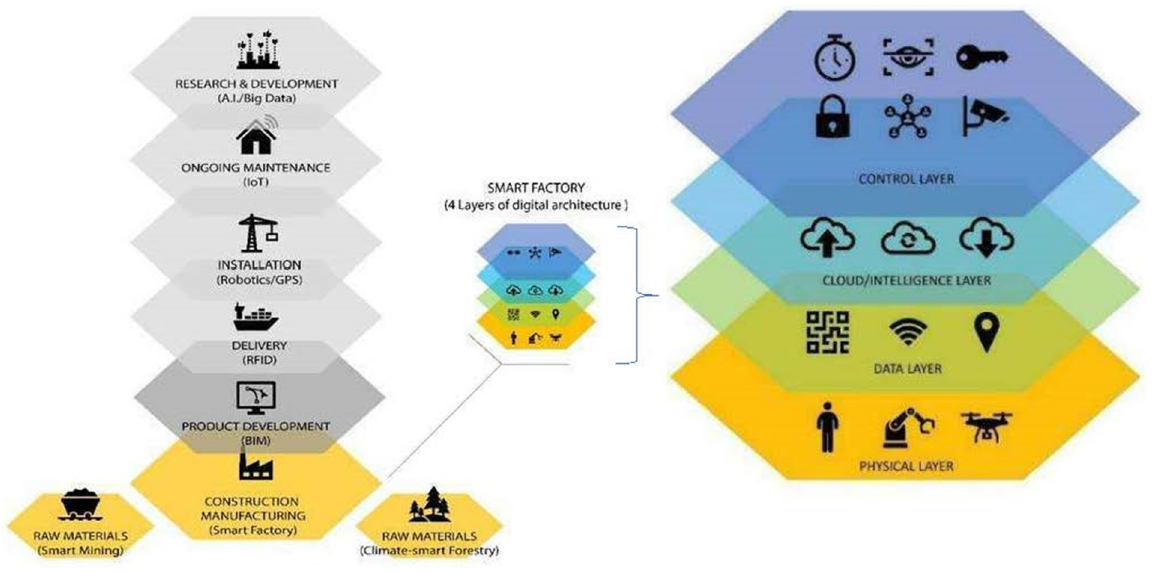
Figure 4. Horizontal and vertical integration in consumer goods manufacturing.